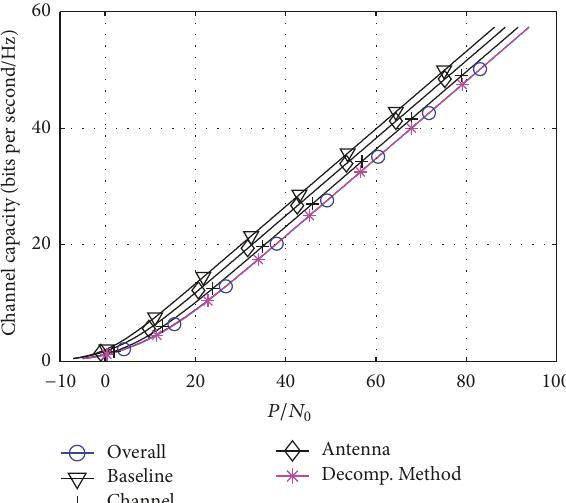
Figure 8: Absolute channel capacity per bandwidth versus 𝑃/𝑁 0 = 10 dB. All measurements including the ideal and using DM; 𝜅 H ant the real result are exhibited. “Overall” and DM results are almost